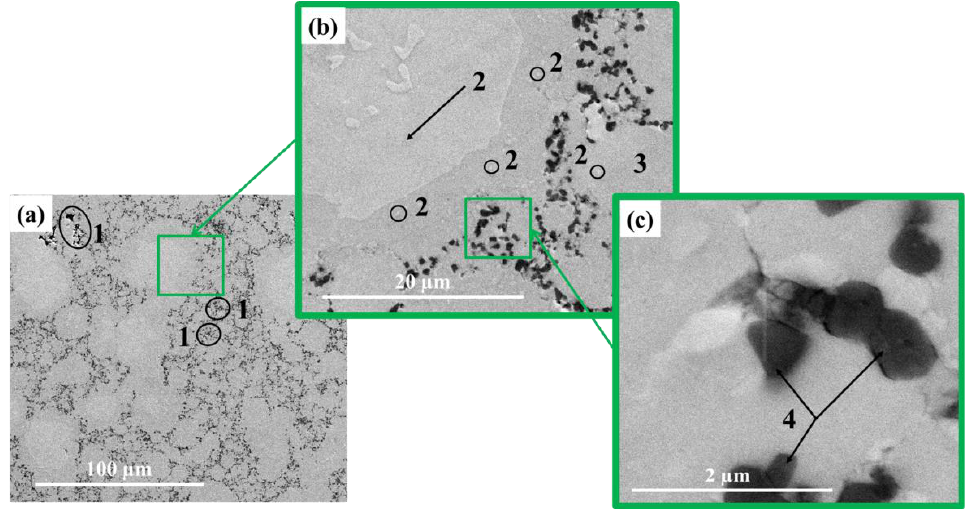
Figure 5. SEM image of materials obtained by MEAM-HP with subsequent sintering at 1200 ± 20 °C: ×1400 ( a ), ×8300 ( b ), × 82 800 ( c )